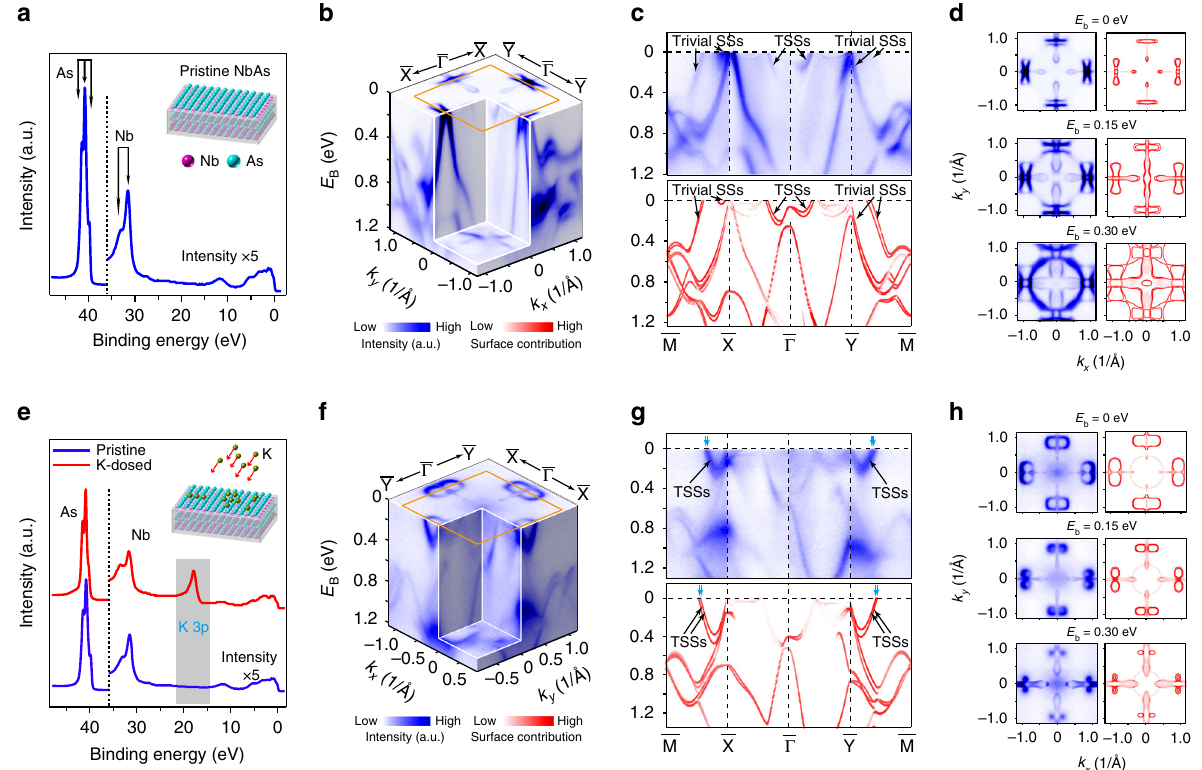
Fig. 3 Measured and calculated band structures of pristine and K – decorated NbAs. a Core-level photoemission spectrum of cleaved NbAs (001) surface (pristine), clearly showing the characteristic As and Nb peaks. b 3D intensity plot of the band structure illustrating the band dispersions. c Excellent agreement between measured and calculated band dispersions along high-symmetry directions with trivial surface states (Trivial SSs) and topological surface states (TSSs generating SFAs) marked. d Side-by-side comparison between experiments and calculations, which exhibits good agreement, of three representative constant-energy contours ( E b = 0, 0.15, 0.30 eV). For comparison, these contours are obtained by mirroring the photoemission spectrum with respect to the k y axis. e Core-level photoemission spectrum of K-dosed NbAs, which clearly displays the K 3p peak, and pristine NbAs. f – h : same as b – d but displaying the band structures of K-decorated NbAs. Our measured data agree well with the calculations. In g , Cyan arrows mark band crossings of the TSSs (corresponding to SFAs). (Note that the color scale of the calculated bands represent their surface projection, i.e., the bold red curves represent the surface states while the faded red curves represent bands with strong bulk